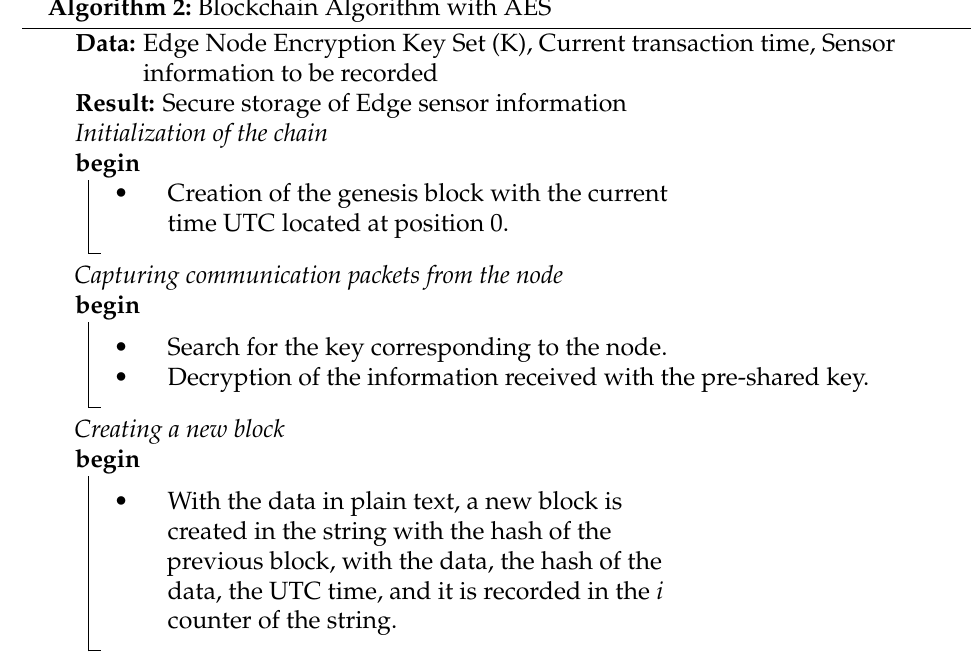
Algorithm 2: Blockchain Algorithm with